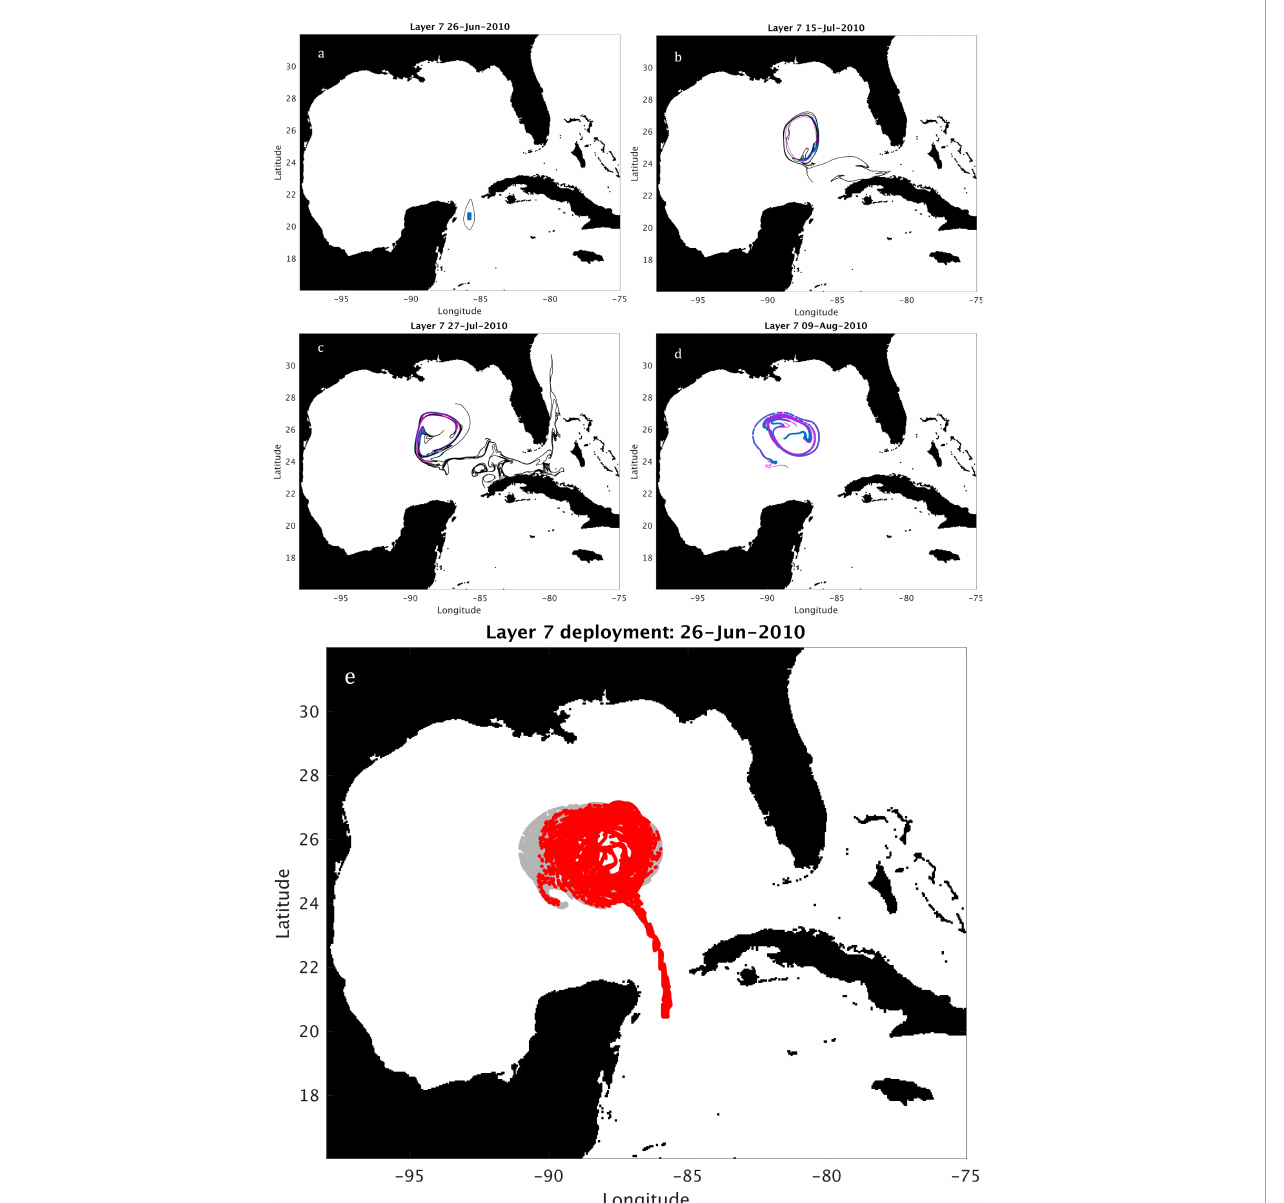
FIGURE 9 (A-D) Snapshots of Lagrangian particle advection, along with the evolution of both the Caribbean anticyclone (black contours) and the LCE boundary (magenta contours). (E) Particle evolution; the blue colors represent trajectories that were traced inside the LCE contour at the end of the 45-day experiment and the gray colors mark trajectories that were traced outside the LCE